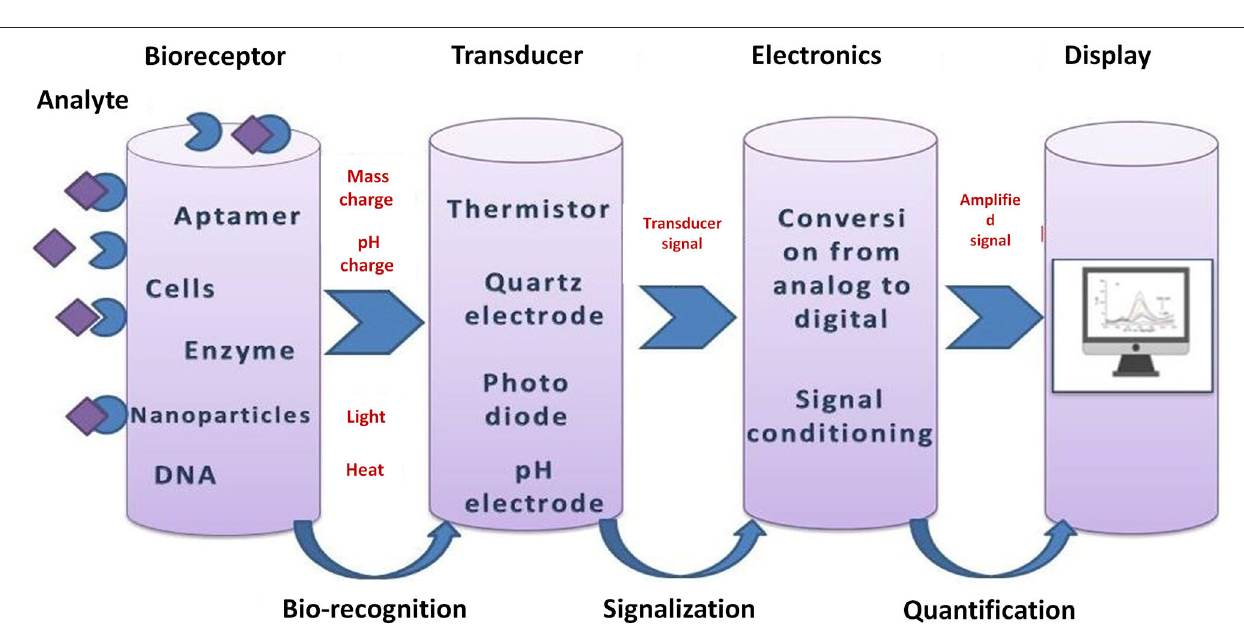
following the morphine oxidation process, as can be seen in Figure 3 . The first one is related to oxidation of phenolic group, forming pseudomorphine. The second reaction is related to oxidation of the tertiary amine group (Navaee et al.,